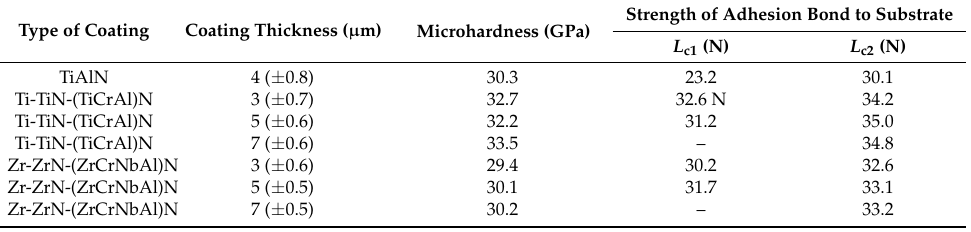
Table 1. Main parameters of the coatings under study.